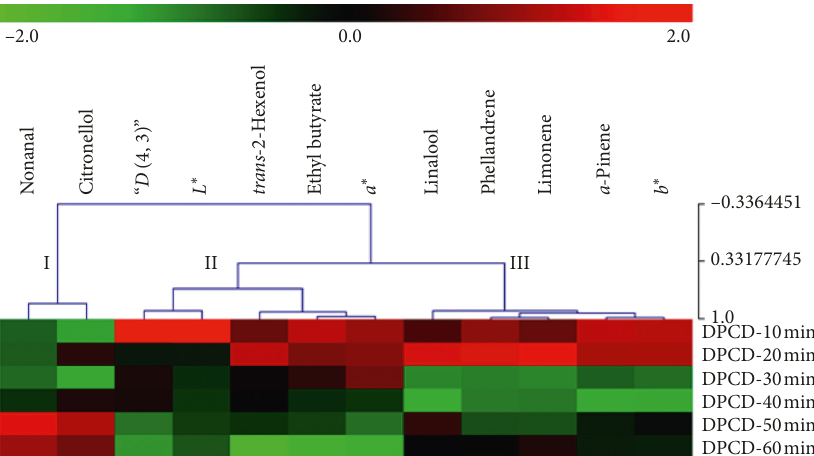
Figure 3: Dendrogram of cluster analysis of the 12 parameters of the DPCD-treated juices (40MPa, 55 ° C). All values in the heat map were transformed into Z -scores and clustered with Euclidean distances.